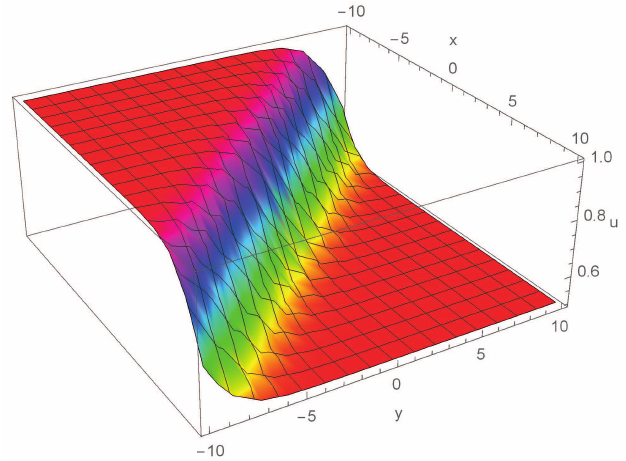
Fig. 4 The surface plot of the PIA solution v 4 ( x , y , t ) for ℜ = 100 and t = 0 . 1 when α = 0 . 85 .